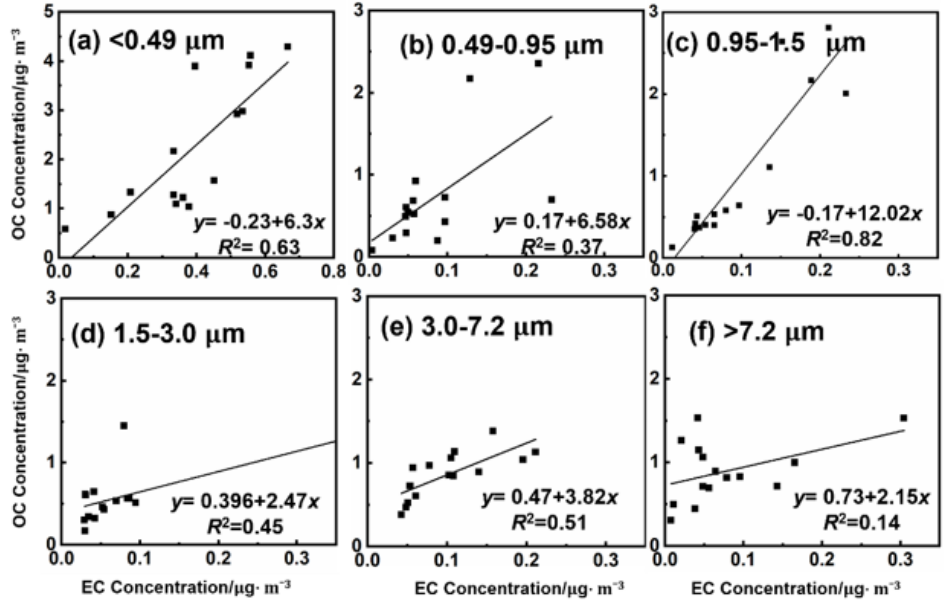
Figure 3. Correlation of OC and EC with particulate size in Lhasa ( a – f ).